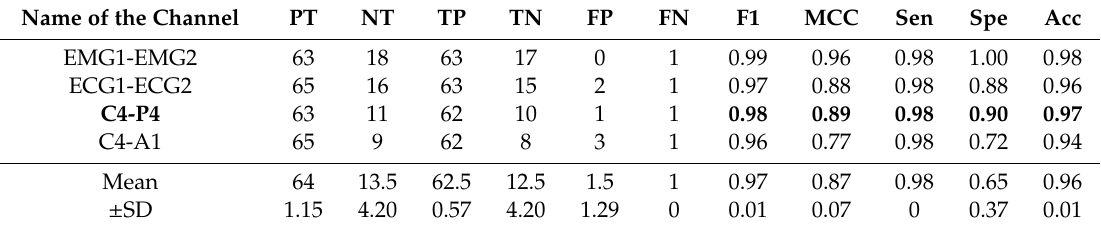
Table 4. Performance for the combination of subjects (bruxism and healthy) and sleep stages (w and REM) classification using the novel 20-fold cross-validation model of the HML classifier. Name of the